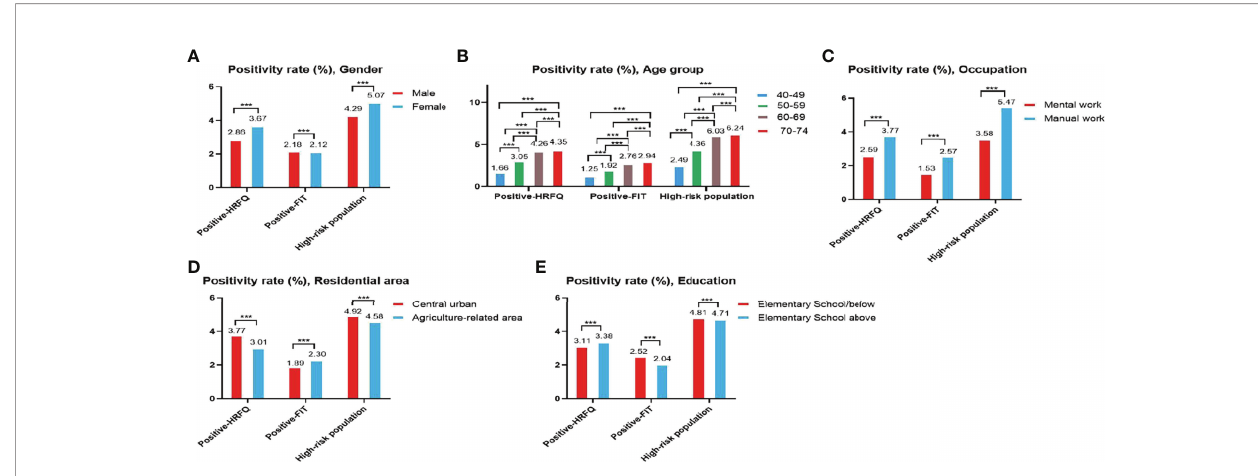
FIGURE 2 | Evaluation of the CRC screening program results by gender (A) , age group (B) , occupation (C) , residential area (D) , education (E) . ***There are signi fi cant differences in detection rates between the different screening methods.